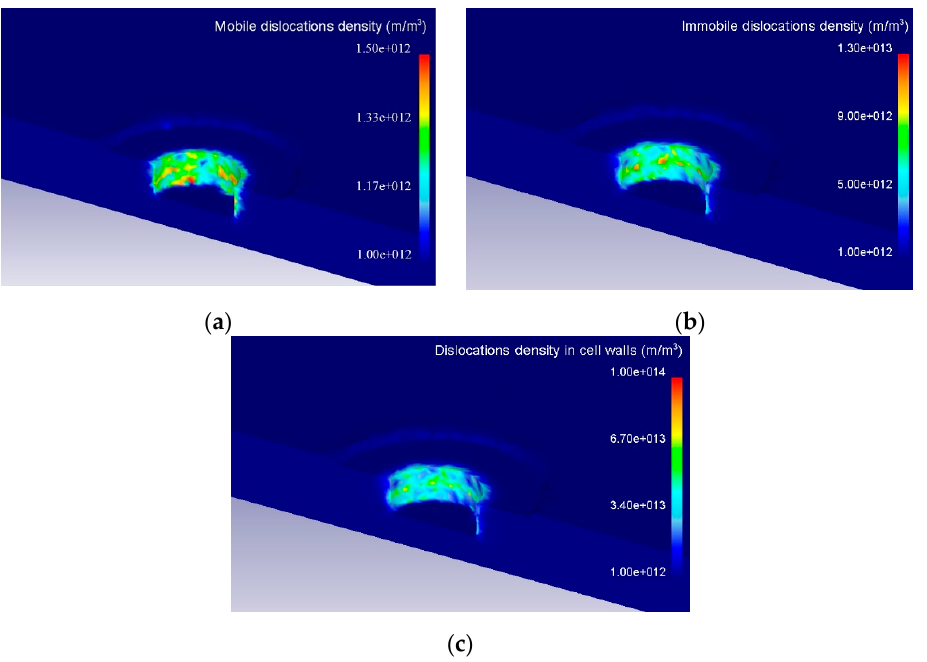
Figure 13. Distribution of ( a ) mobile dislocations density; ( b ) immobile dislocations density in cell interior; ( c ) dislocation density in cell walls. (FSSW parameters: rotating speed 1600 rpm, plunge rate 72 mm/min, plunge depth 2.2 mm, and dwell time 3 s).